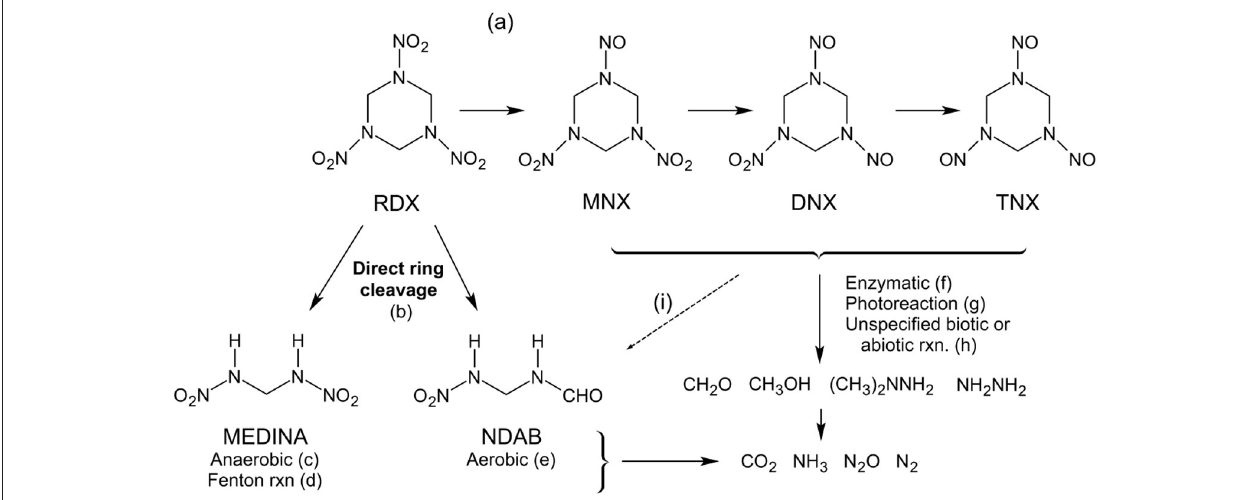
FIGURE 9 | RDX transformation and mineralization reaction pathways. HMX degradation follows identical pathways, and is not shown here for simplicity. References: a, Juhasz and Naidu (2007), McCormick et al. (1981), Van Aken et al. (2004), Hawari et al. (2001), and Sheremata et al. (2001); b, Ariyarathna et al. (2016), Halasz and Hawari (2011), Smith et al. (2015b), Liou et al. (2003), and Hawari et al. (2001); c, McCormick et al. (1981), Jackson et al. (2007), and Hawari et al. (2000c); d, Liou et al. (2003) , Oh et al. (2003), and Zoh and Stenstrom (2002); e, Jackson et al. (2007) and Monteil-Rivera et al. (2008); f, Van Aken et al. (2004); g, Van Aken et